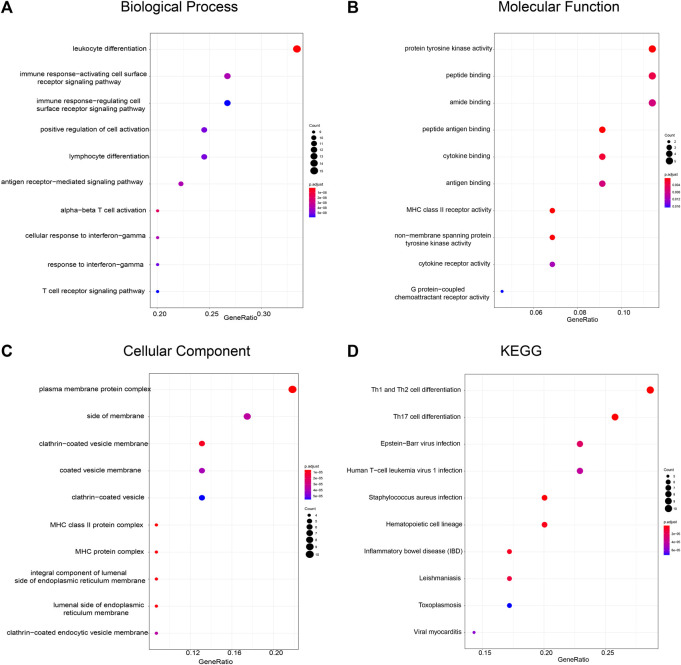
Functional enrichment analysis of FPR3-related gene module (A) Biological process (B) Molecular function (C) Cellular component, and (D) KEGG pathways are depicted. The color of the dots demonstrates -Log10(FDR). Red dots indicate smaller FDRs than blue dots. The size of the dots indicates the number of genes enriched in each analysis.